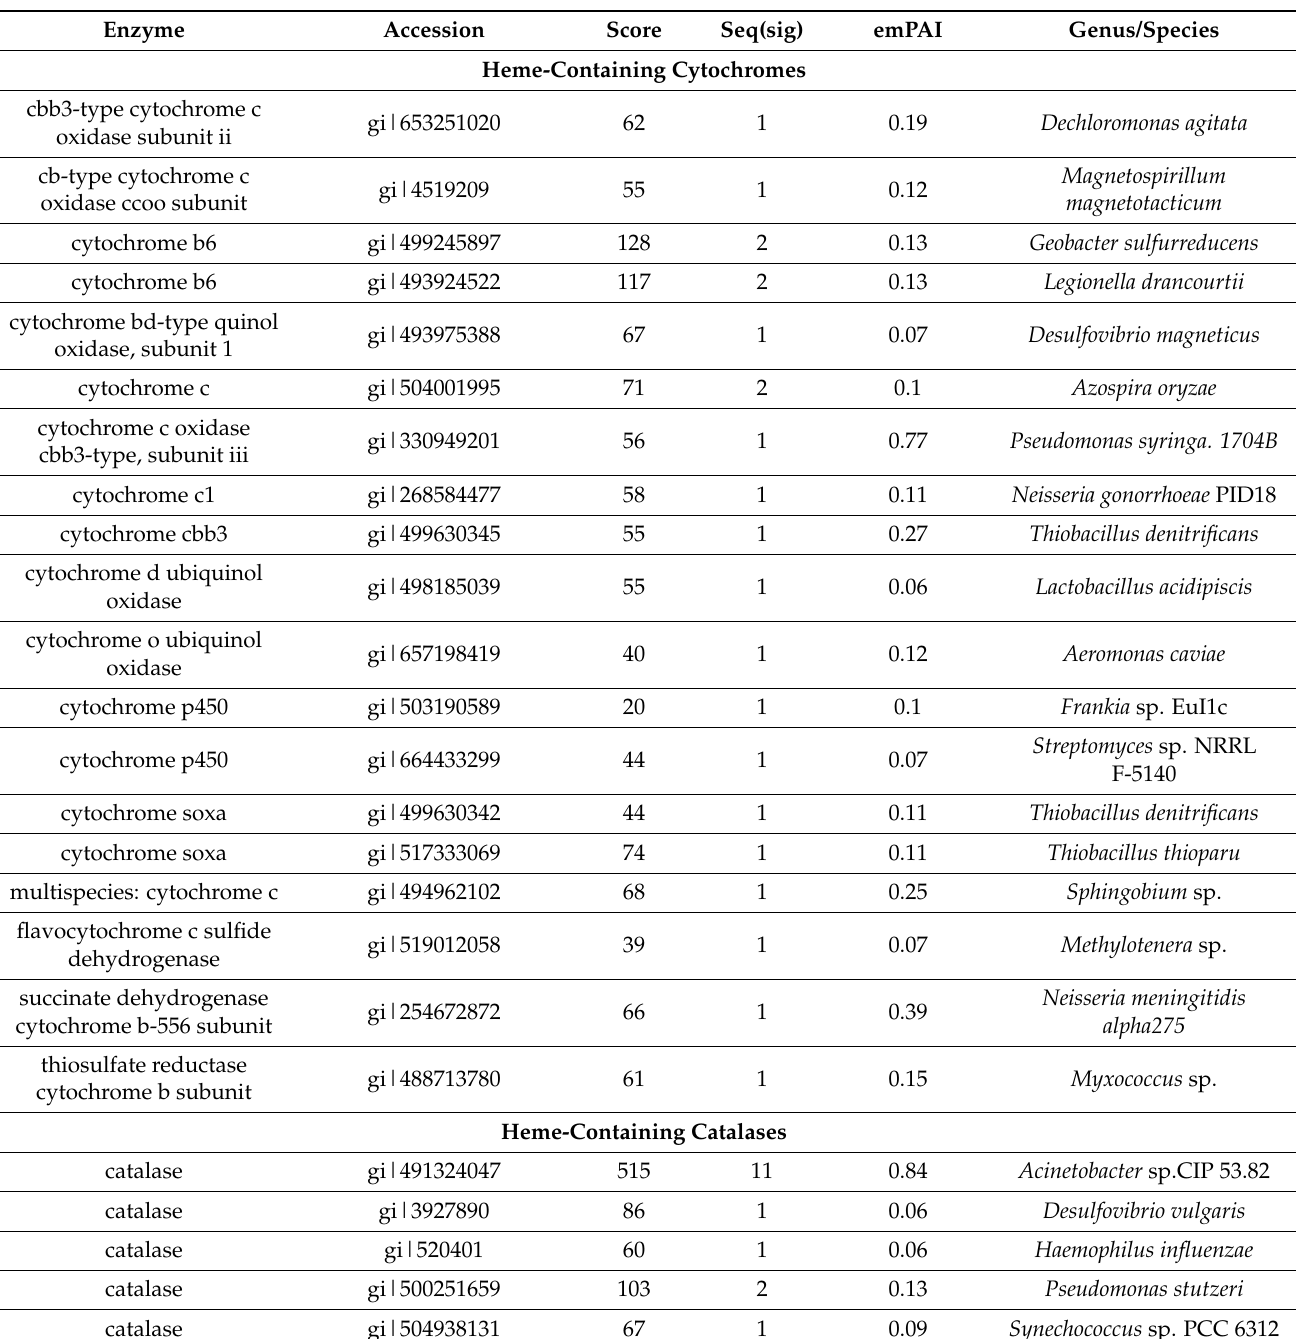
Table 2. Enzymes containing tetrapyrrole cofactors detected in the studied metaproteome of bacterial